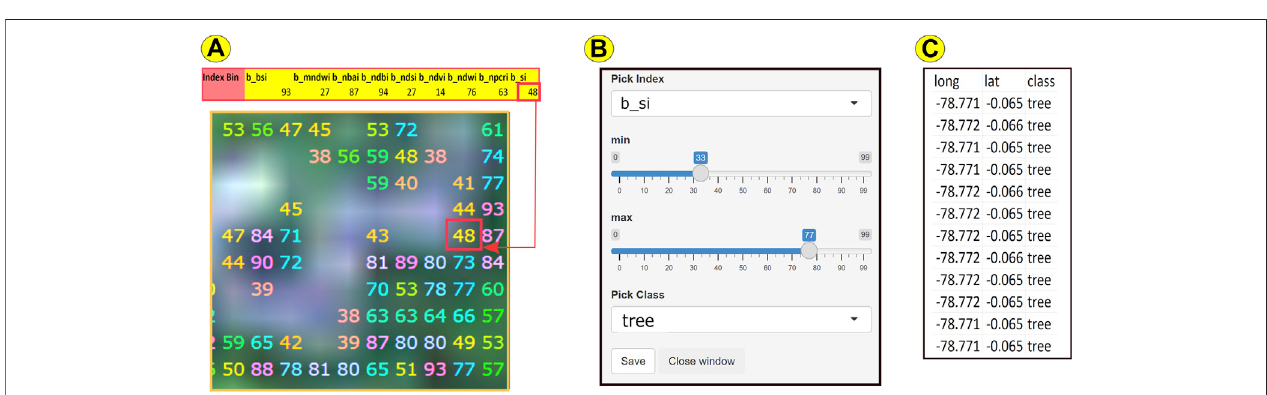
FIGURE 7 | The raster above (A) is the upper-right cross-section of the raster featured in Figure 6 , with a red square around the same pixel from Figure 6 . Within each tile, for each raster index for each pixel, we took the 99% percentile value of the index, which werefer to asthe Index Bin. For example, the selected pixelhad an SI (shadow index, used to monitor tree canopy) value of 255.97 (see Figure 6 ). The pixel has an SI Index Bin (b_si) value of 48. To annotate or tag a pixel, we developed a Shiny, interactive application (B) for our R package, loRax . In the example above, we selected “ b_si ” from the drop-down box and manipulated the scroll bars to selectminimum/maximumvaluesof33/77.ColorednumberscorrespondingtotheIndexBinvaluesofeachpixelwithinthisrangeappearedontherasterimage (A) .After comparingtheresultingimagewiththehigherresolutionAirbusimage(see Figures1D,E ),weselectedtheclass “ tree ” fromanotherdrop-down list (B) tosavetheclass and location of the selected pixels to fi le (C)